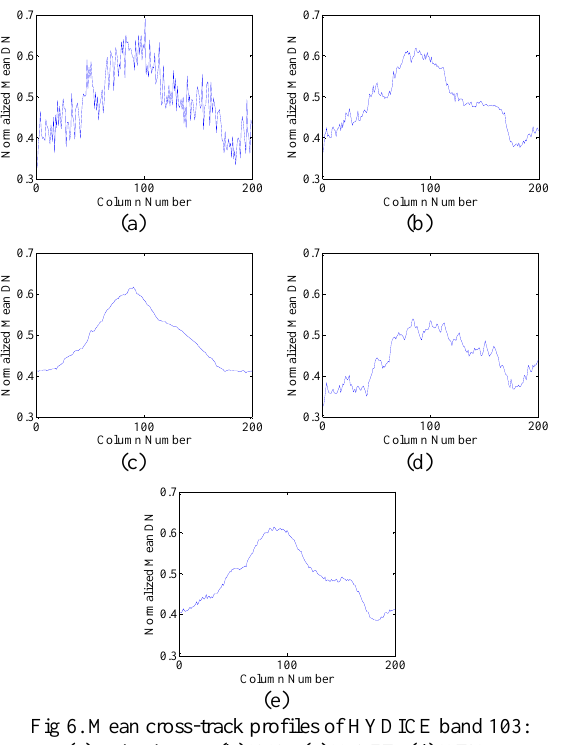
Fig 6. Mean cross-track profiles of HYDICE band 103: (a) noisy image; (b) MM; (c) WAFT; (d) UTV; and (e) the proposed method.